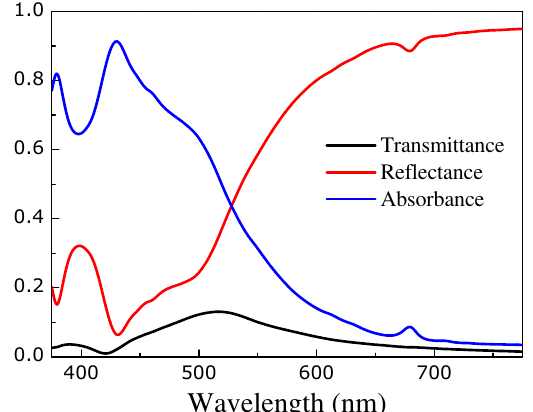
Figure 2. Transmittance, reflectance and absorbance of light incident normally on a square array (of lattice constant a = 350 nm) of silver nanocubes with edge L = 70 nm, separated by a 8 nm polyelectrolyte ( ǫ = 2 . 37 ) spacer from a 50 nm thick gold substrate (see Figure 1).